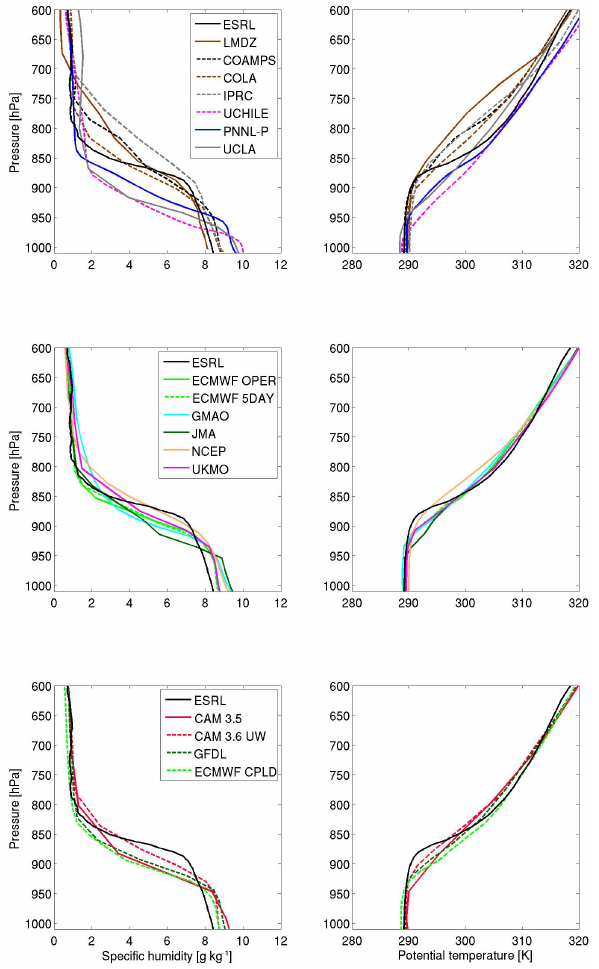
Fig. 8. Soundings of specific humidity (left, kgkg − 1 ) and potential temperature (right, K) at 20 ◦ S 85 ◦ W. Model soundings are Oc- tober 2006 means for regional (top), operational (middle) and cli- mate (bottom). NOAA/ESRL soundings (black) are an average of several-day October periods in multiple years (see text).